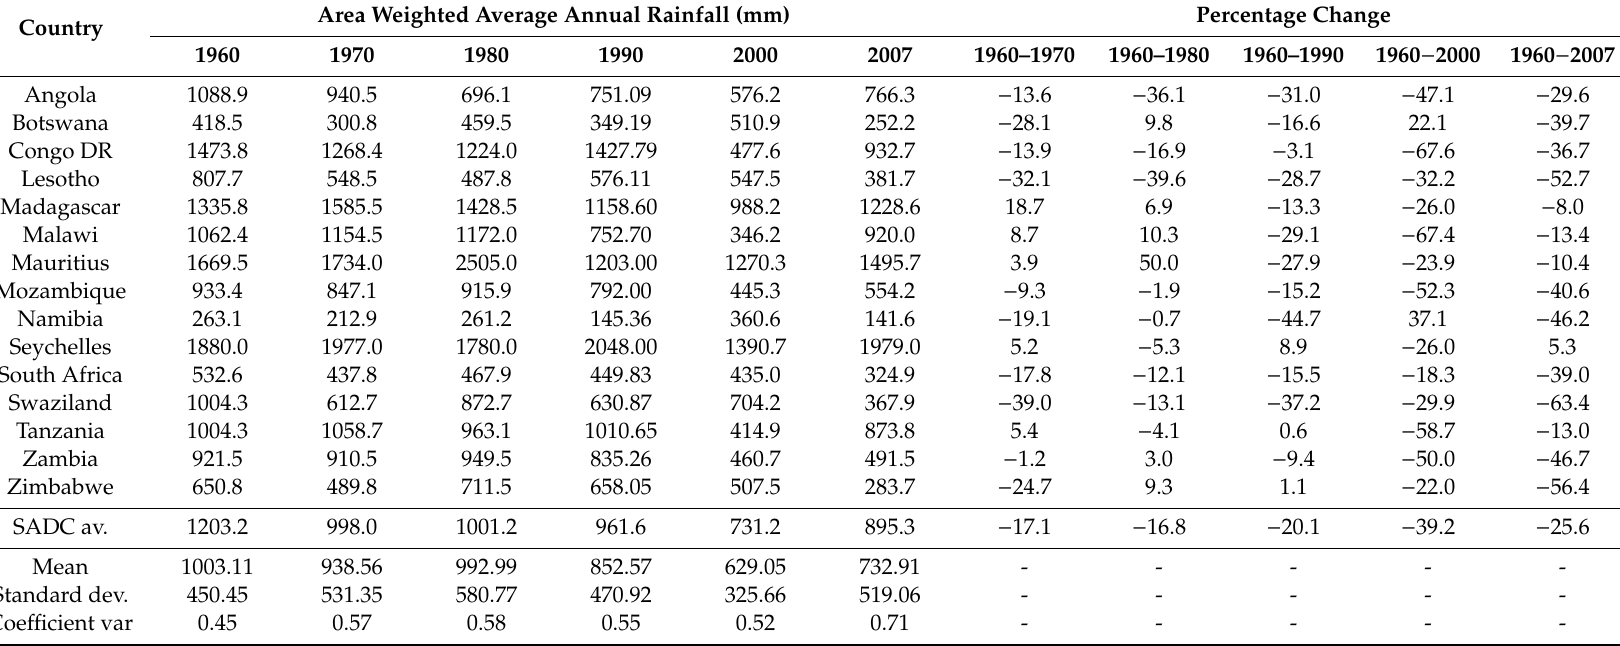
Table 2. Temporal change in total annual rainfall in the Southern African Development Community (SADC) countries from 1960 to 2007 Area Weighted Average Annual Rainfall (mm) Country